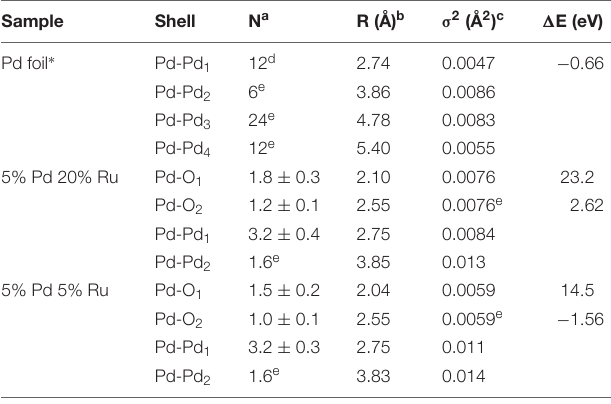
TABLE 2 | EXAFS structural parameters of the palladium foil and biogenic Pd-Ru NPs. Sample